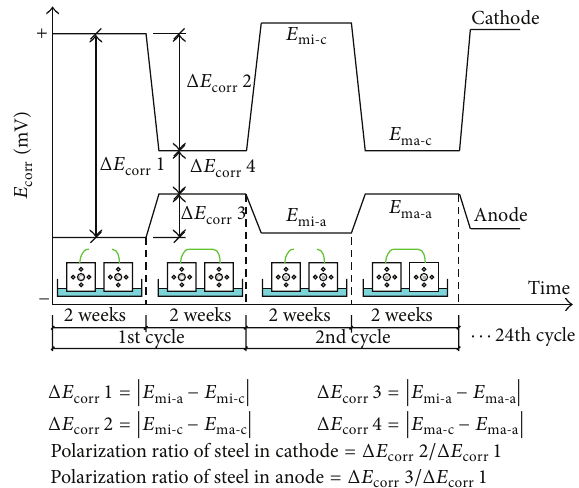
Figure 6: Definition of potential difference of macrocell